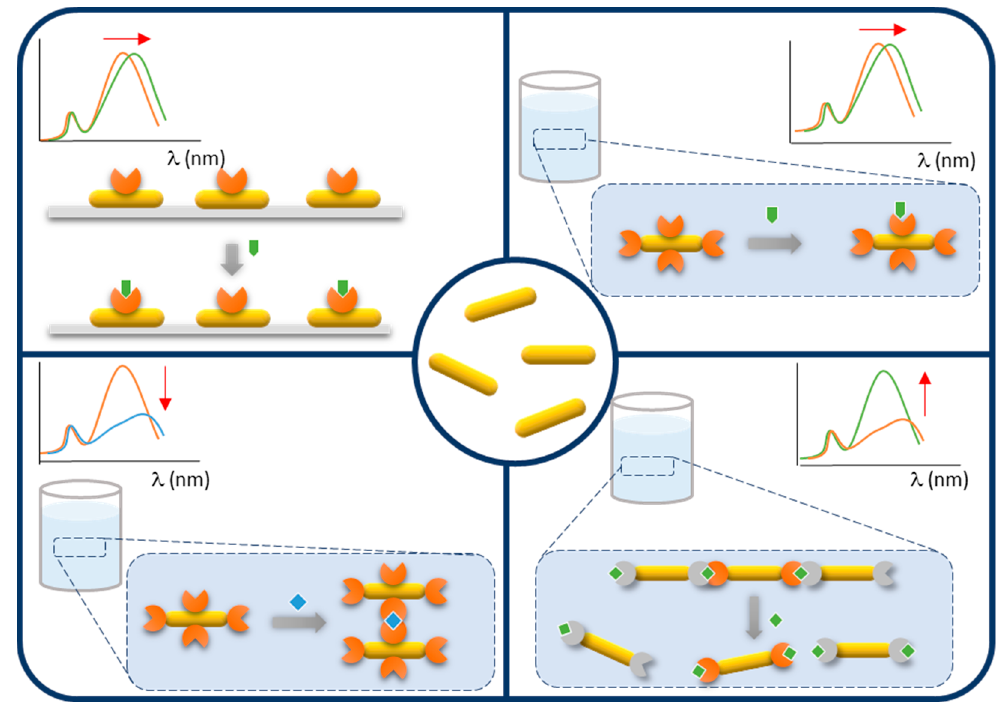
Figure 22. Summary of the operating configurations for Gold Nanorods nanoplasmonic biosensors.